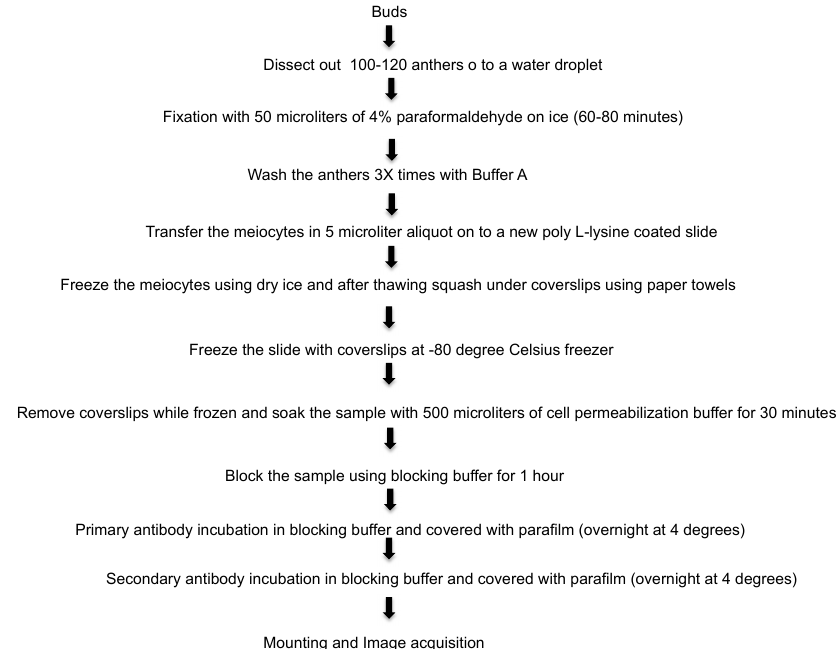
Figure 5. Complete steps for the meiotic chromosomal proteins and spindle immunolocalization technique.